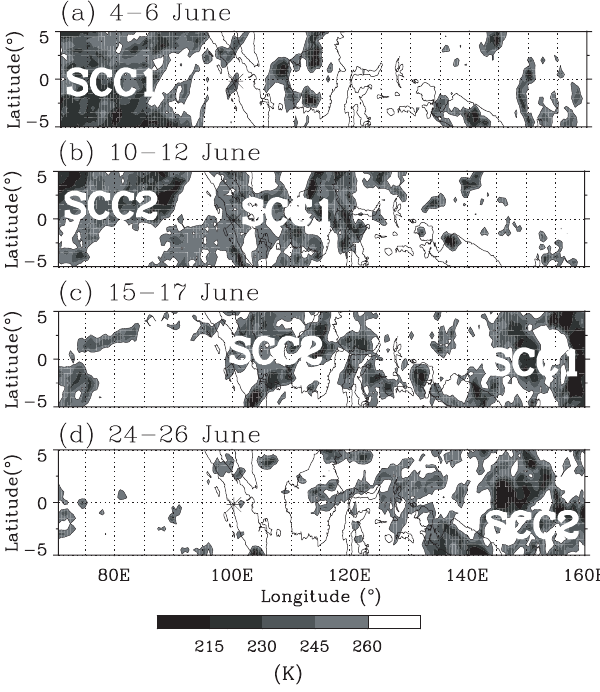
Fig. 4. Longitude-latitude plots of T BB averaged over (a) 4–6, (b) 10–12, (c) 15–17, and (d) 24–26 in June 2002. “*” in each panel indicates the location of the observation